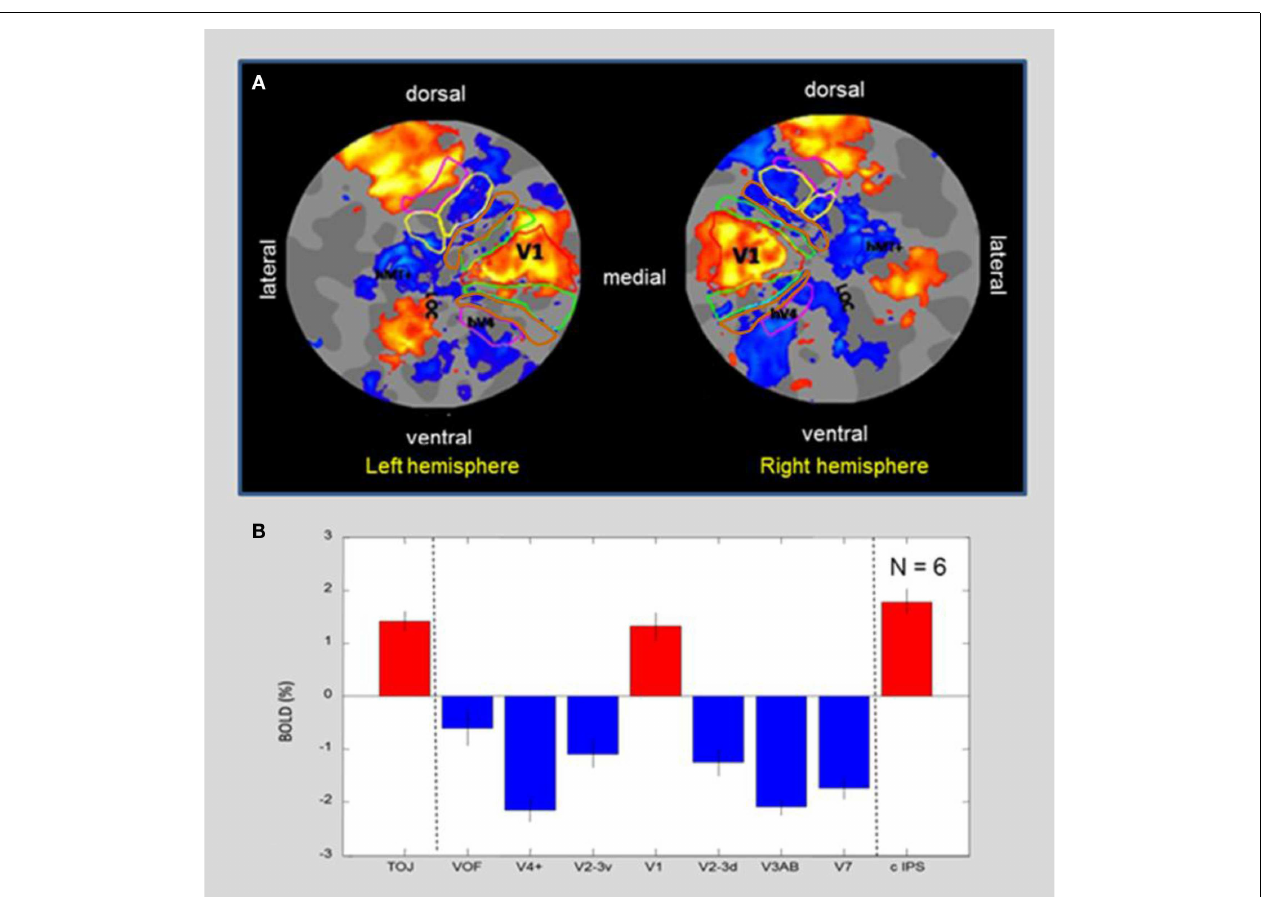
the caudal intraparietal sulcus (cIPS) dorsally and an additional locus at the occipitotemporal border (LOtv). (B) Average response amplitude with standard errors for blindfolded memory-guided drawing in a group of six subjects, showing positive signal in the triad of areas – primary visual areaV1, cIPS, and LOtv; these three “islands” of positive activation are separated by strong deactivation in both the ventral and the dorsal extrastriate areas. Error bars represent 1 standard error of the